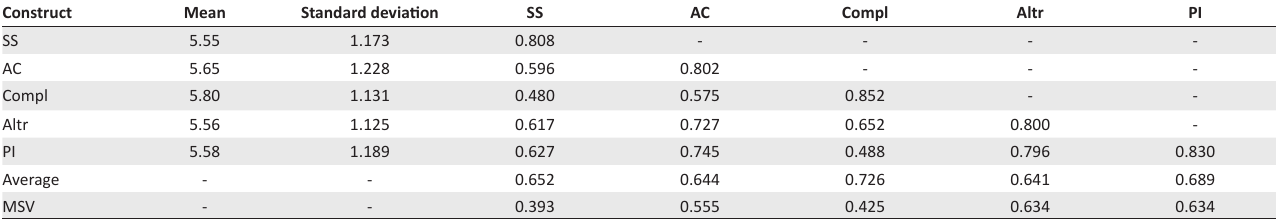
TABLE 3: Descriptives, construct correlation and